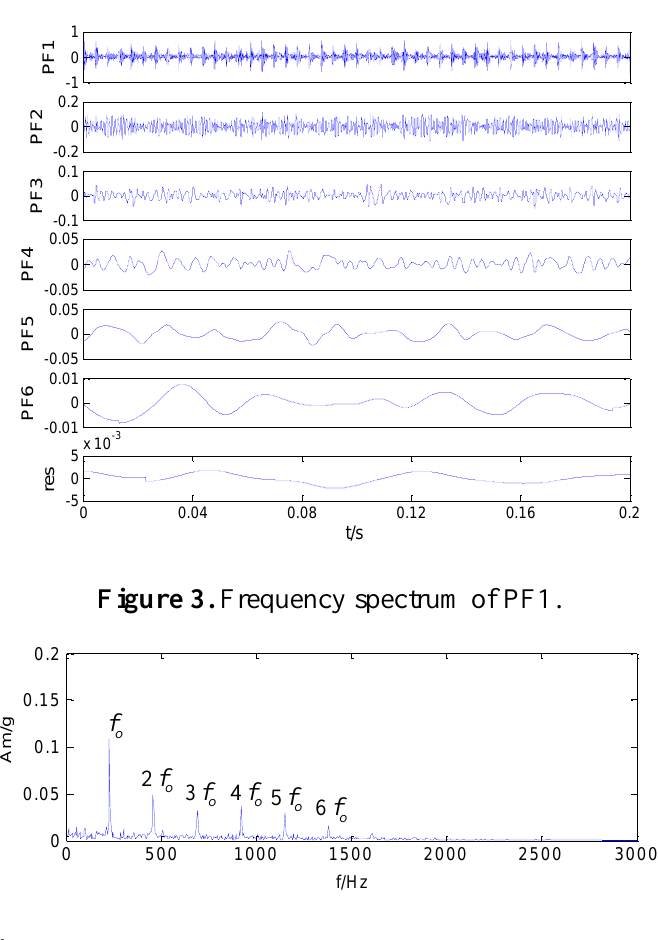
Figure 3. Frequency spectrum of